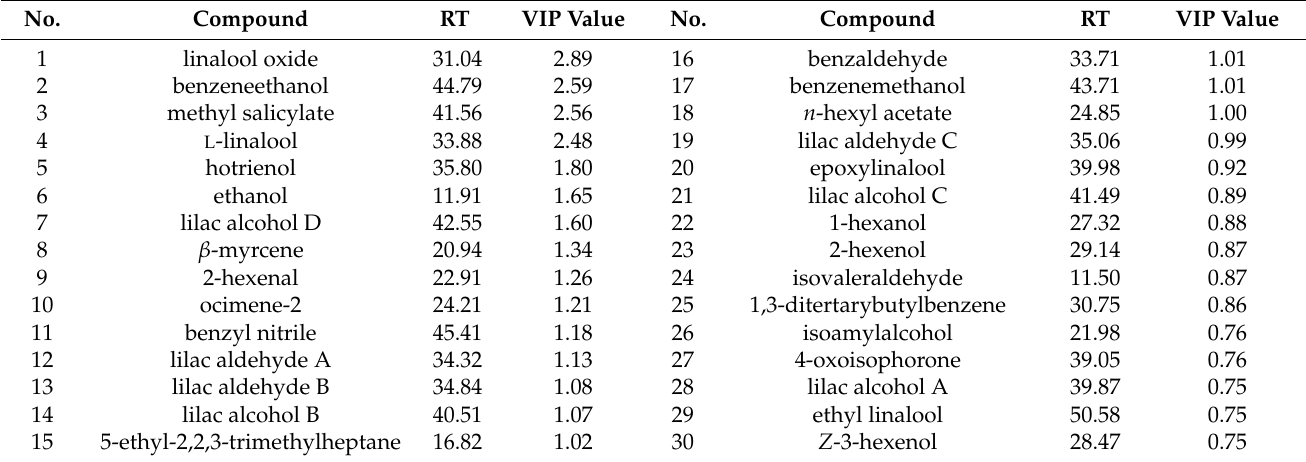
Table 2. The variable influence on projection (VIP) values (>0.7) of the volatile components for the separation between the flowers in five variants of Abeliophyllum distichum in the PLS-DA-derived score plots. No.